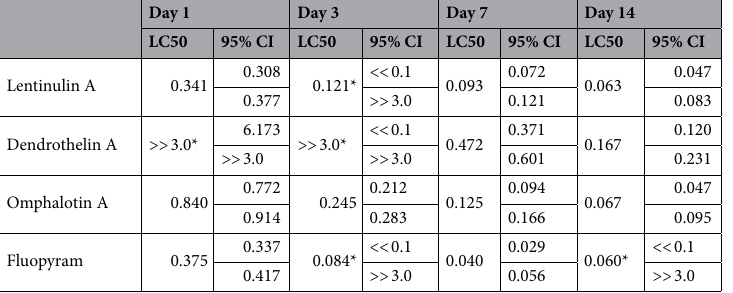
Table 1. In vitro nematotoxicity of recombinant omphalotin A, lentinulin A and dendrothelin A towards M. incognita. The nematotoxicity of the three macrocycles was determined at different concentrations and exposure times on M. incognita second-stage juveniles (J2) as described in Materials and methods. Shown are the estimated lethal concentrations 50% (LC50) in μM and the 95% confidence interval (95% CI) on those estimates. * indicates that the statistical model did not adequately fit the data and thus that the values are less confident (see Supplementary Dataset 1 for raw data and Supplementary Fig. S8 for statistical analysis). The nematicide fluopyram was used as positive